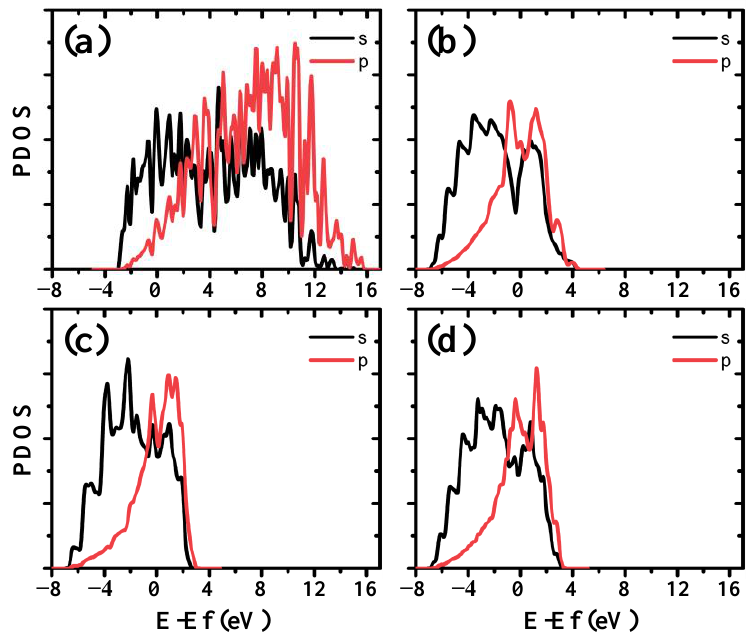
Figure 5. PDOS of a single Mg atom in the ( a ) Mg bulk structure, ( b ) the topmost layer of Mg(0001) surface, ( c ) the topmost layer of Mg(1120) surface, and ( d ) the topmost layer of Mg(1011 ) surface. The Fermi level is set at 0 eV.